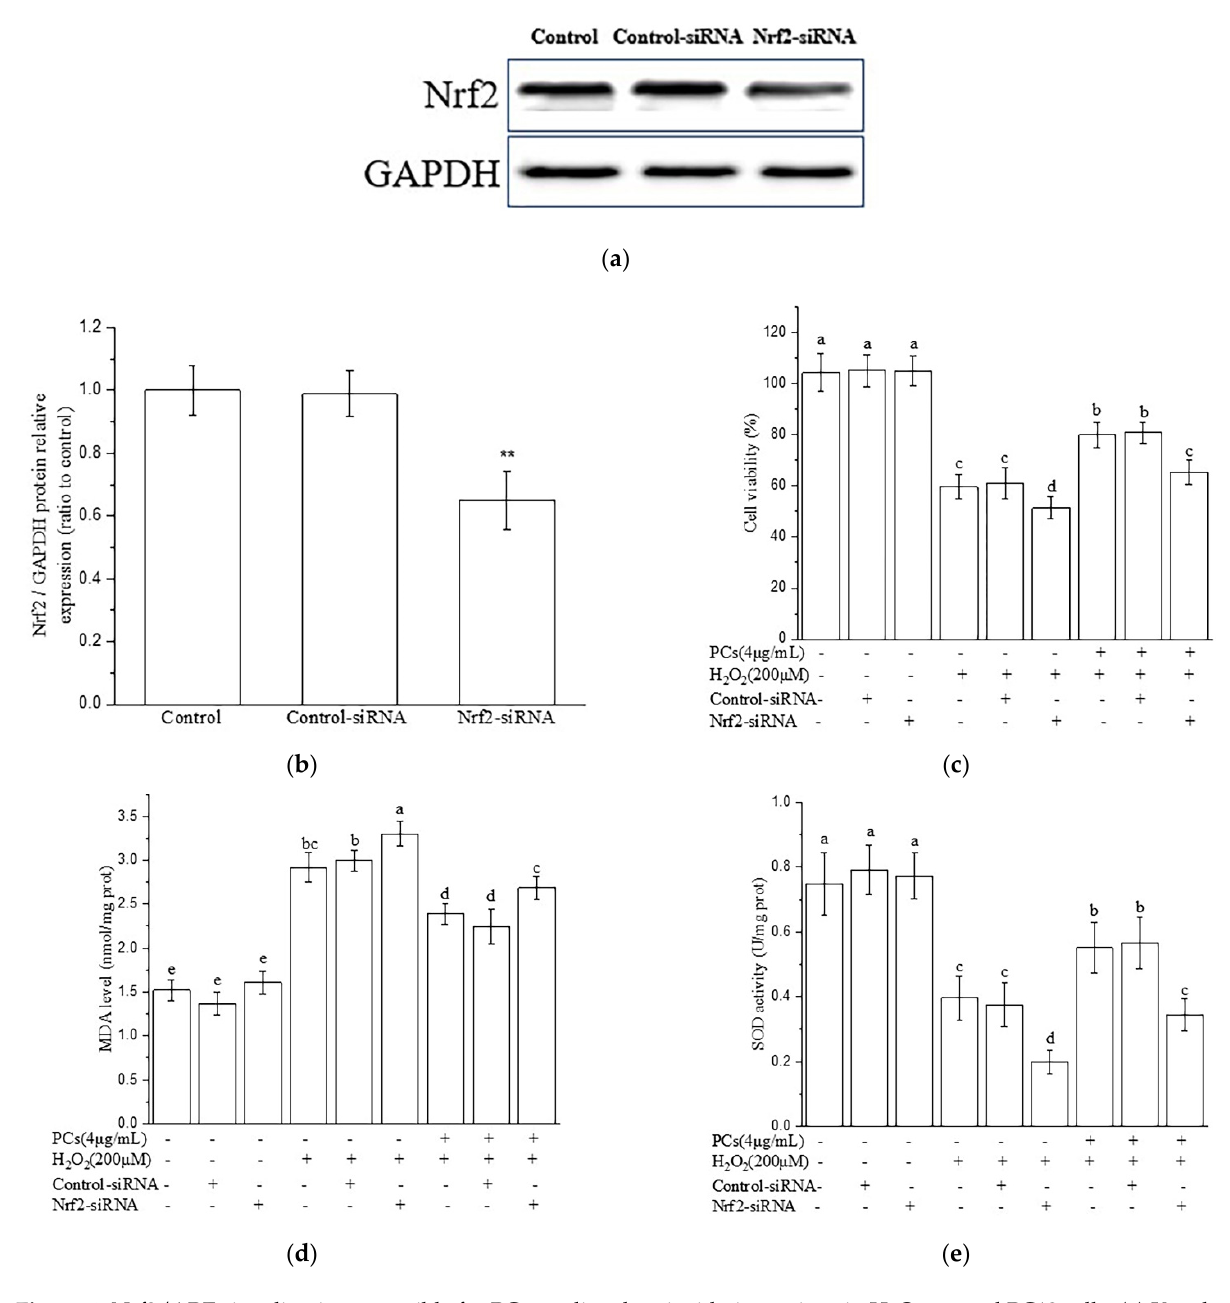
Figure 4. Nrf2/ARE signaling is responsible for PCs-mediated antioxidative actions in H 2 O 2 -treated PC12 cells. ( a ) Knock- out efficiency was detected by determination of Nrf2 protein expression using Western blotting; ( b ) Nrf2/GAPDH protein relative expression (ratio to control); ( c ) cell viability; ( d ) MDA levels; ( e ) SOD activity. Data are expressed as the mean ± SD. All experiments were conducted three times. Values with different letters above are significantly different, ( p < 0.05, ** p < 0.01 relative to control group, one-way ANOVA).